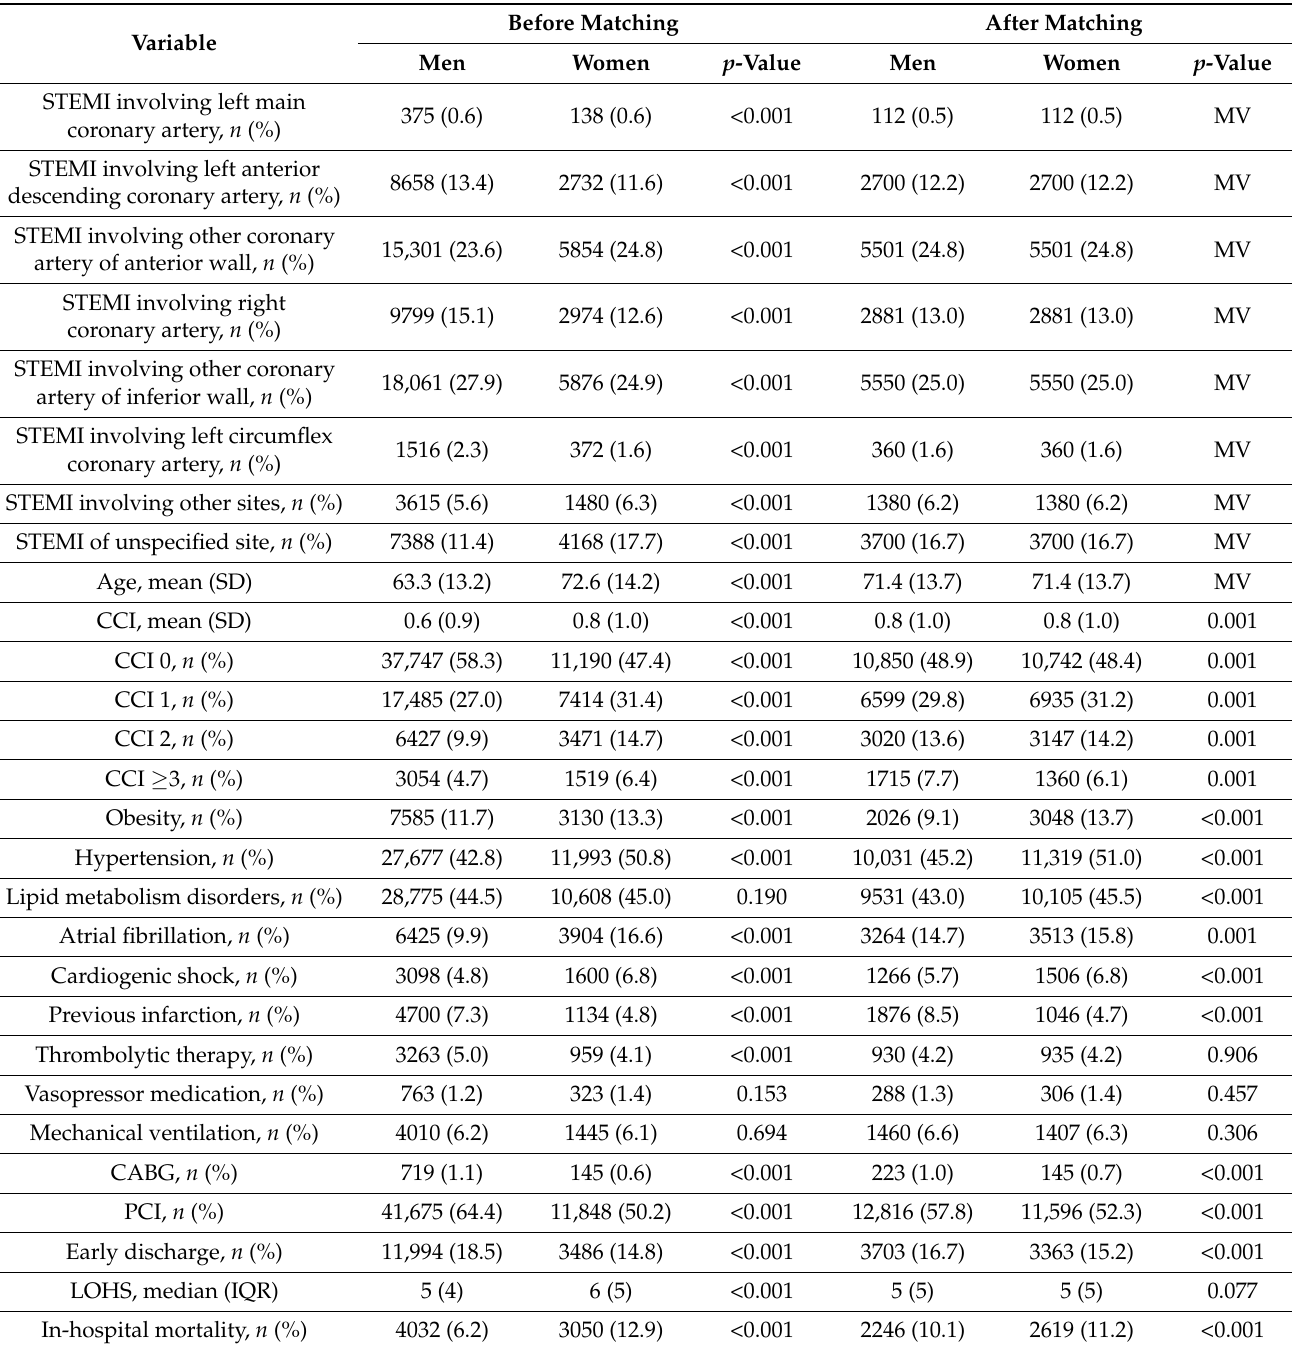
Table 2. Clinical characteristics and hospital outcomes, before and after matching by age and myocardial infarction type (ICD-10), for men and women suffering from an